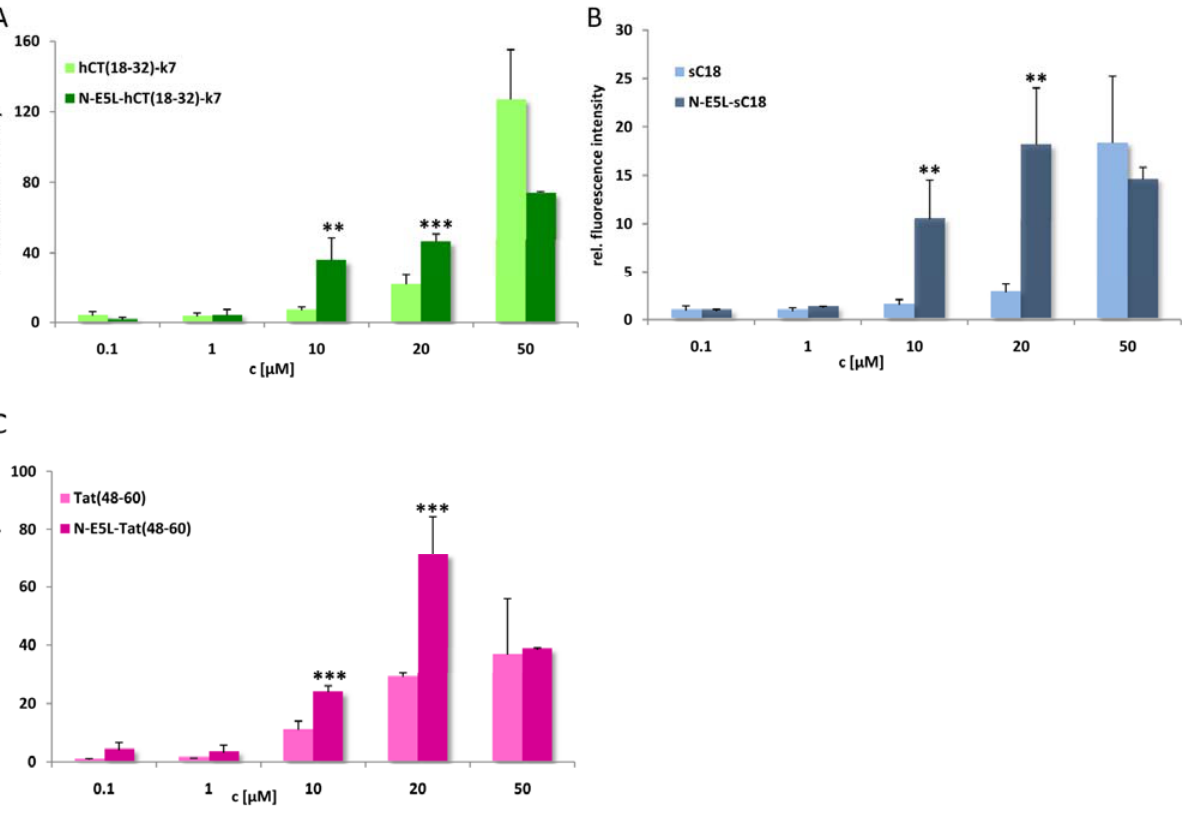
Figure 7. Cellular uptake of CF-labelled hCT(18-32)-k7 and N-E5L-hCT(18-32)-k7 (a), sC18 and N-E5L-sC18 (b), and Tat(48-60) and N-E5L-Tat(48-60) (c) after incubation of HeLa cells 10 min with several peptide concentrations. Modification with the N-E5L peptide leads to higher uptake values. At concentrations > 30 µM a cytotoxic influence of the chimeric peptides is observed. (Values were compared by using student’s unpaired t- test, p < 0.01**; p <